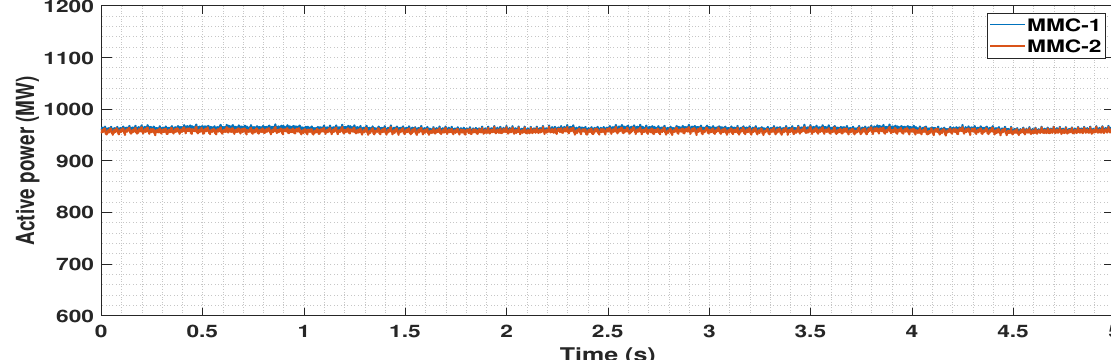
Figure 24. Active power in MMC-1 and MMC-2 buses upon connecting all OWFs with 500 MW generation